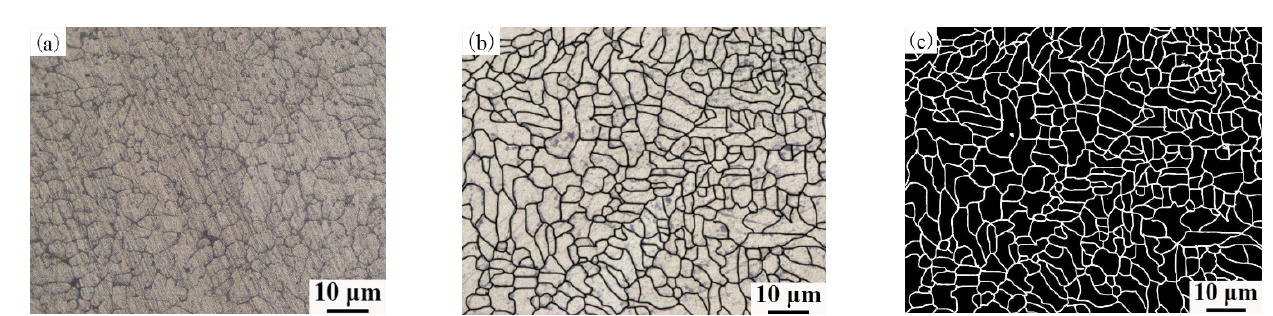
Figure 5. Metallographic structure processing for OABs: ( a ) primary metallographic structure; ( b ) after the grains were